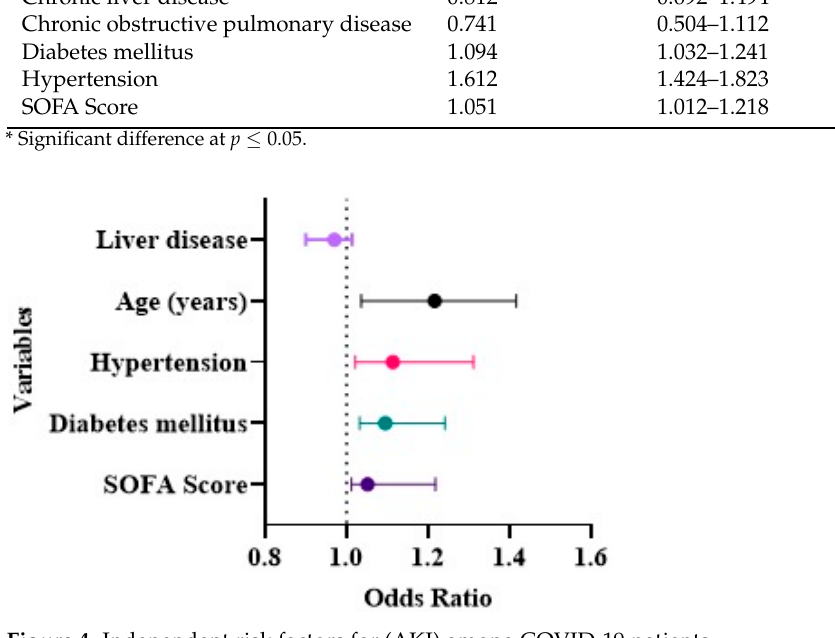
Figure 4. Independent risk factors for (AKI) among COVID-19 patients.